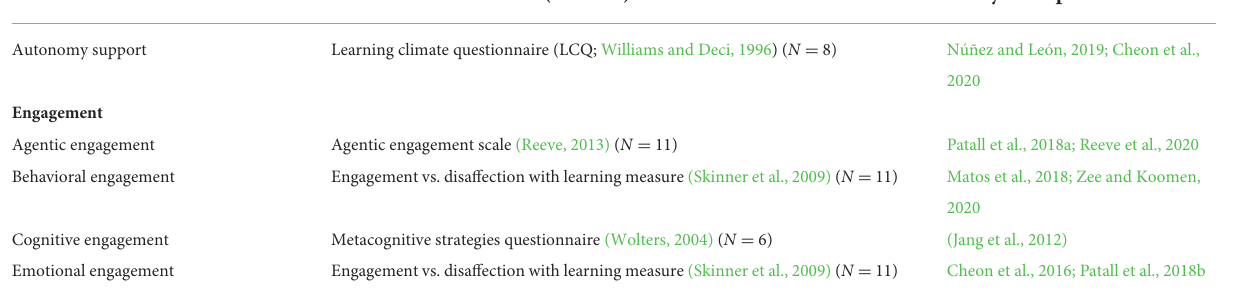
TABLE 10 Most frequently used